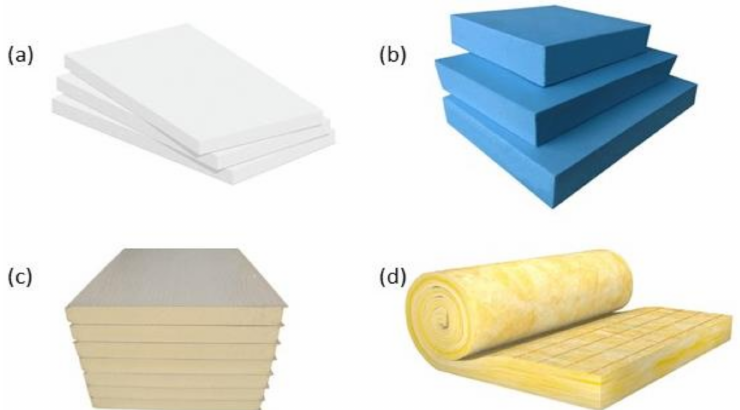
Figure 3. Insulating materials: ( a ) Expanded polystyrene boards ( b ) Extruded polystyrene boards; ( c ) Polyurethane foam insulation panels; ( d ) Fiberglass roll